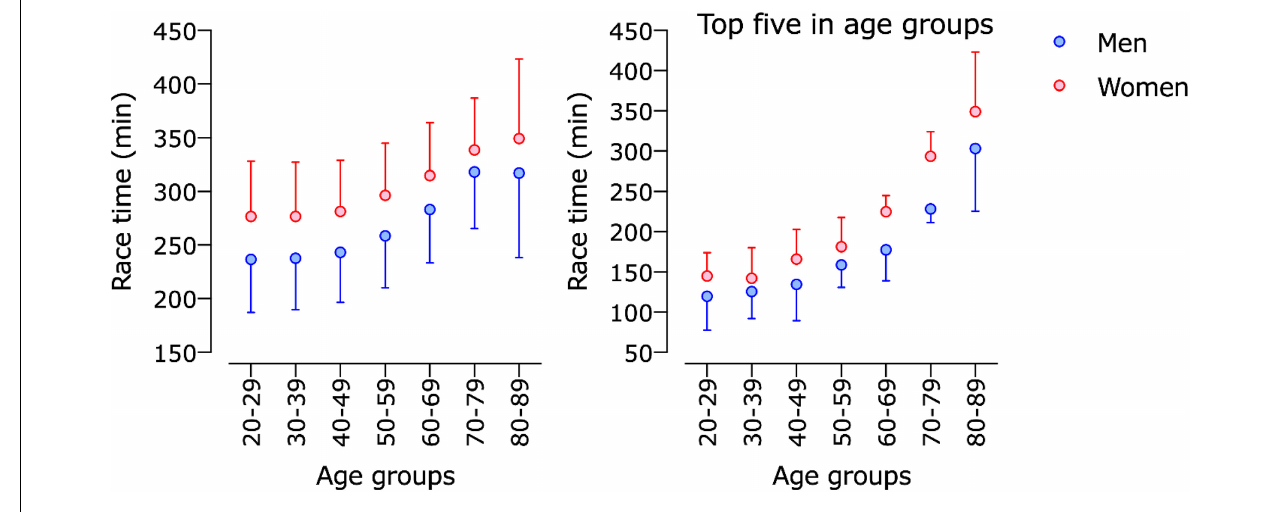
FIGURE 3 | Race time of men and women in “Berlin Marathon” across age groups.